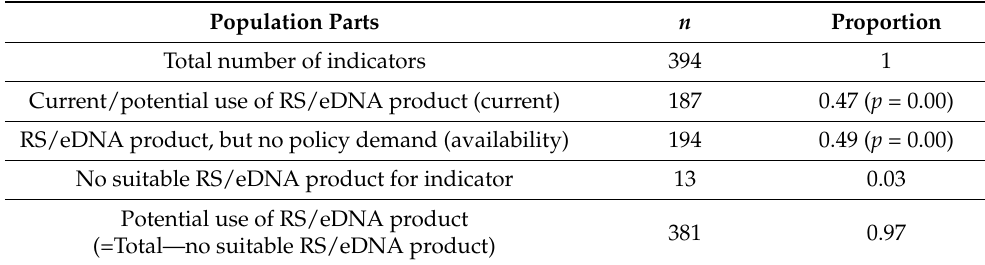
Table 2. The proportion of current forest conservation indicators that can be monitored with RS/eDNA biodiversity products ( p values from one sample z-test). Population Parts n Proportion Total number of indicators 394 Current/potential use of RS/eDNA product (current) 187 0.47 ( p = 0.00) RS/eDNA product, but no policy demand (availability) No suitable RS/eDNA product for indicator 381 0.97 (=Total—no suitable RS/eDNA product)